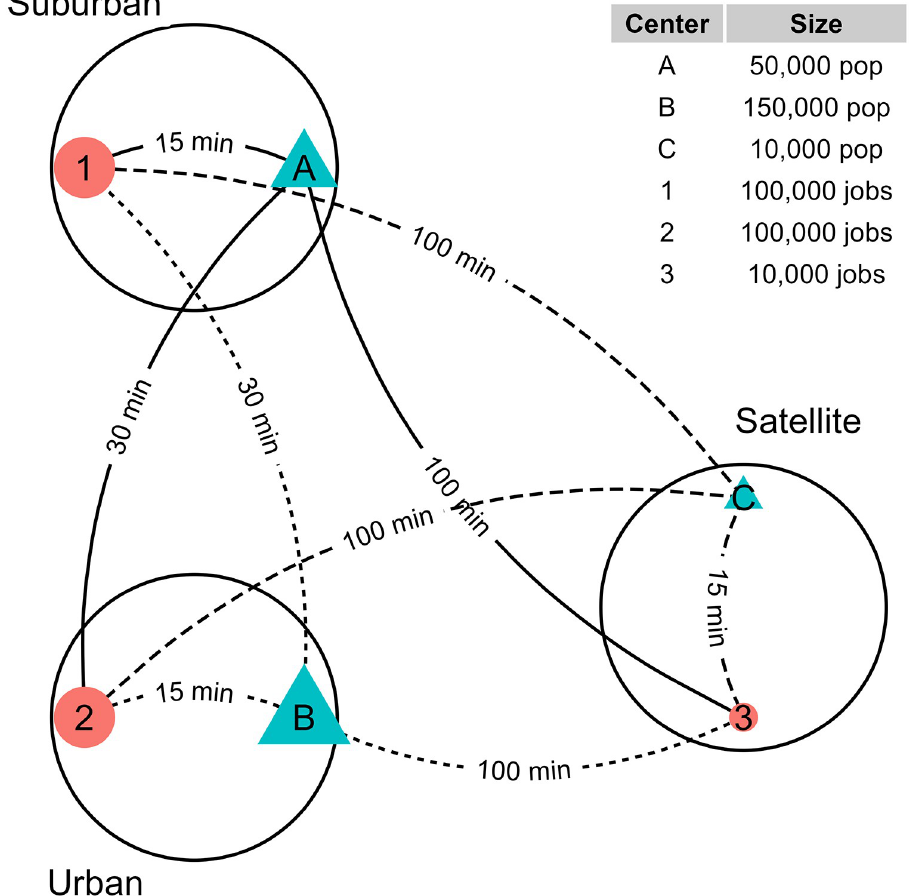
Fig 2. Shen (1998) synthetic example with locations of employment centers (in orange), population centers (in blue), number of jobs and population and travel times.